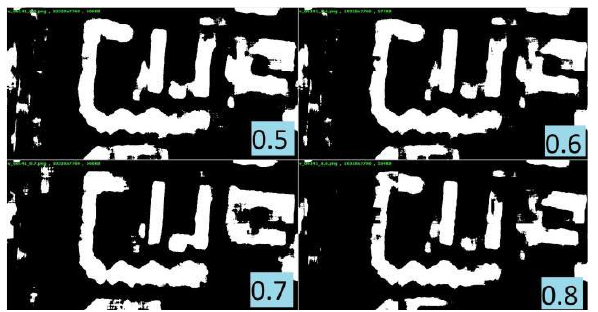
Figure 2 . The comparison of the masks with different binarization coefficients. The coefficient is shown in the lower right corner of each mask.